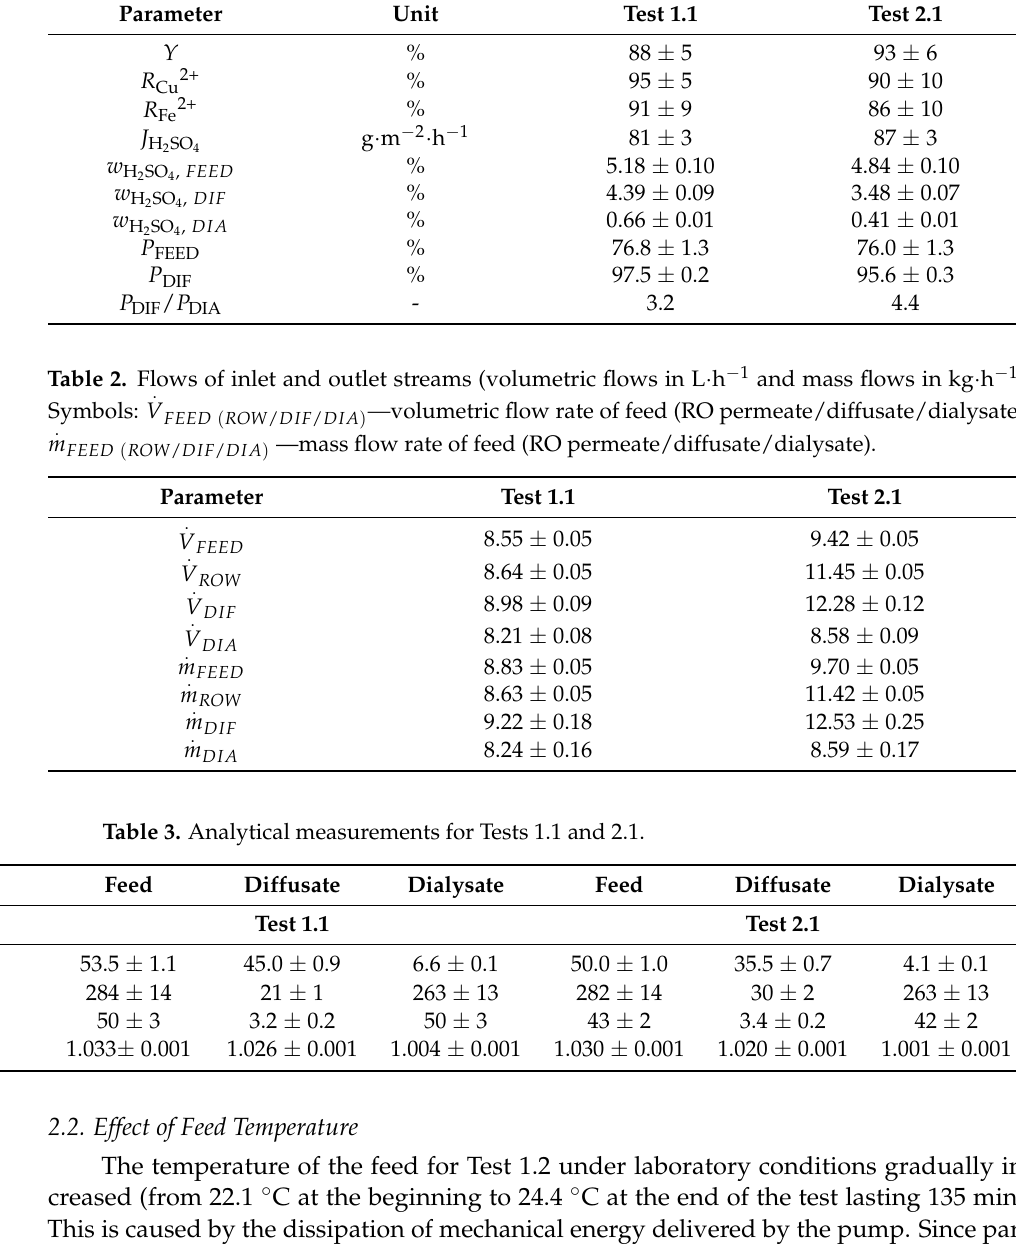
Table 1. Summarized values for performance parameters used for Tests 1.1 and 2.1. Sym- bols: Y —yield of acid, R Cu2+ —rejection of Cu 2+ , R Fe2+ —rejection of Fe 2+ , J H